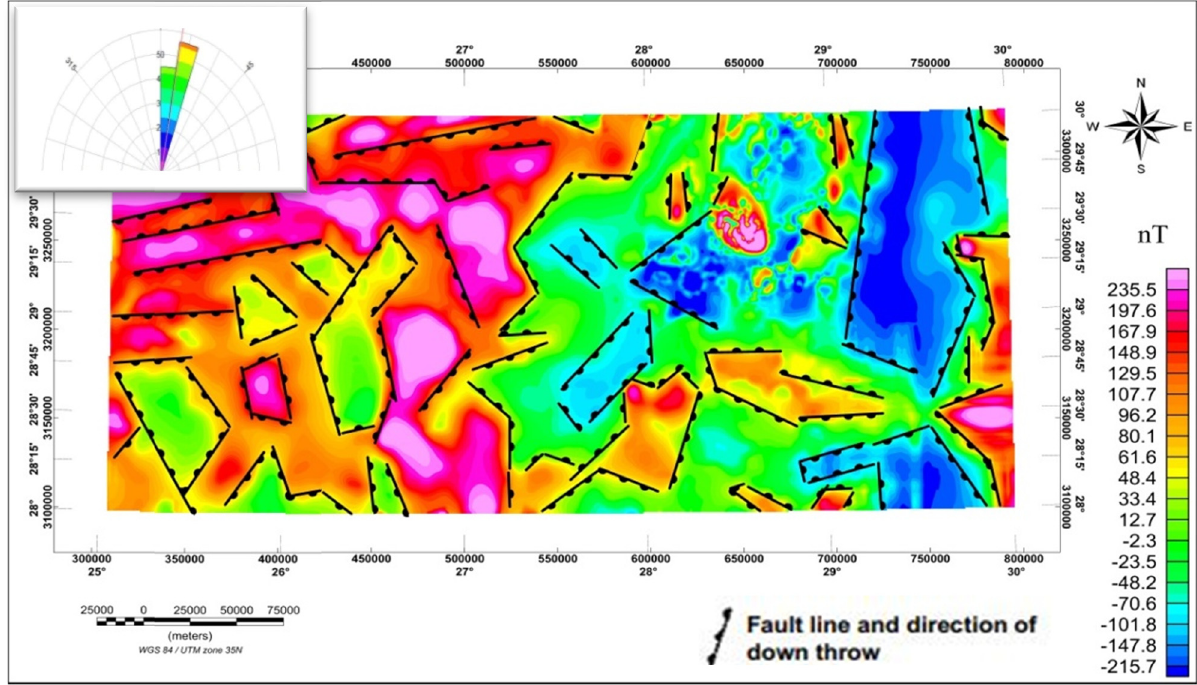
Figure 14: Magnetic lineaments and corresponding azimuth frequency